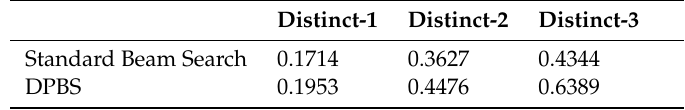
Table 1. Diversity statistics of the standard beam search and the Diversity-Promoting Beam Search (DPBS) method.